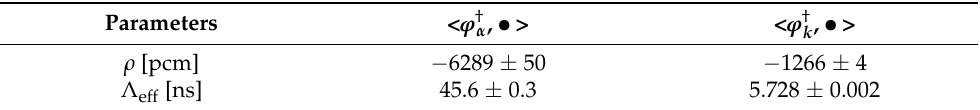
Effective kinetics parameters of Problem I, sub-critical configuration without delayed contributions.